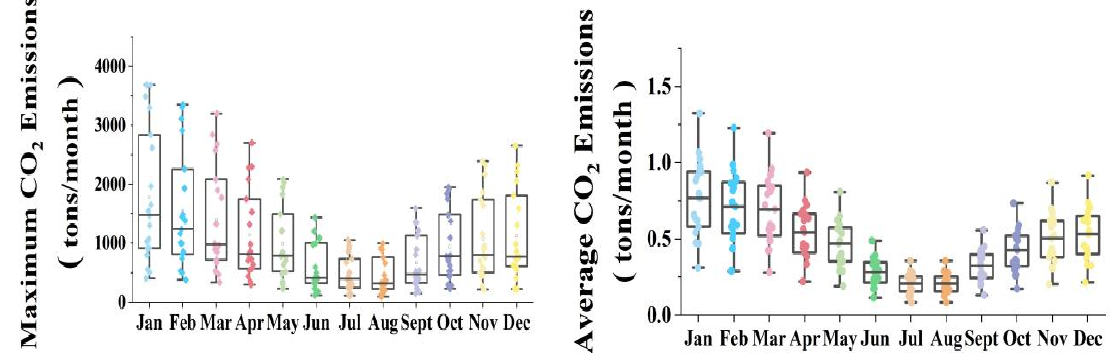
Figure 8. Boxplot of maximum and average CO 2 emissions. Each point represents the average or maximum CO 2 emissions of a county. The five horizontal lines from top to bottom represent the largest observed value, the 75% quantile, the median, the 25% quantile, and the smallest observed value, respectively. Points outside the horizontal lines at either end are outlier points.